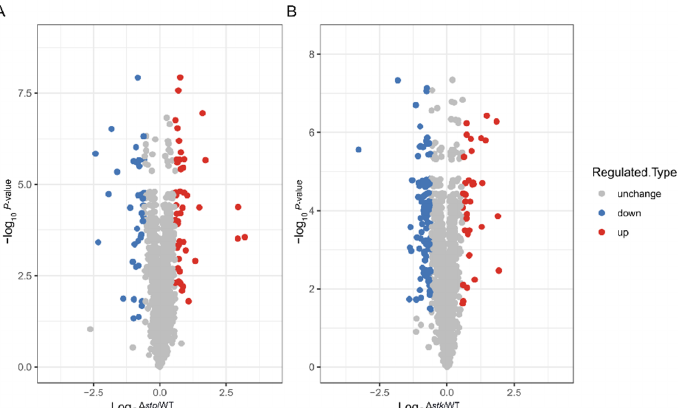
Figure 5. Comparative proteomic analysis between the WT and ∆ stp or ∆ stk strains. Volcano plots showing the differentially expressed proteins in ∆ stp ( A ) or ∆ stk ( B ) compared to WT strain. Fold change > 1.5 and p < 0.05 is regarded as significant change. Blue dots represent down-regulated proteins, red dots represent up-regulated proteins, and grey dots represent proteins with no significant change.